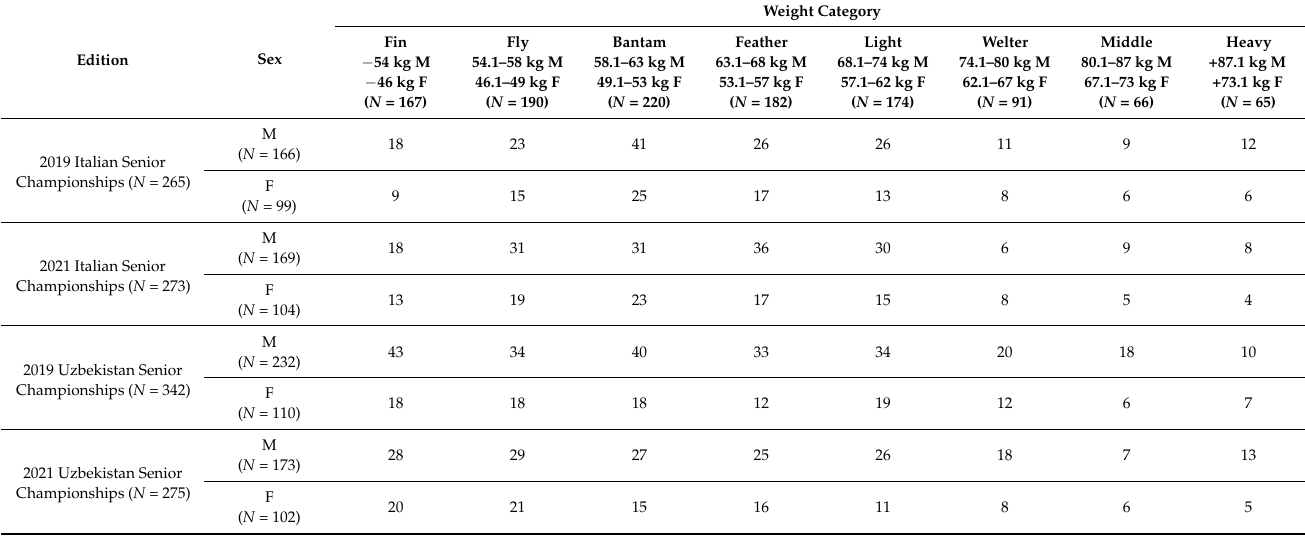
Table 1. Number of matches in each National Senior Taekwondo